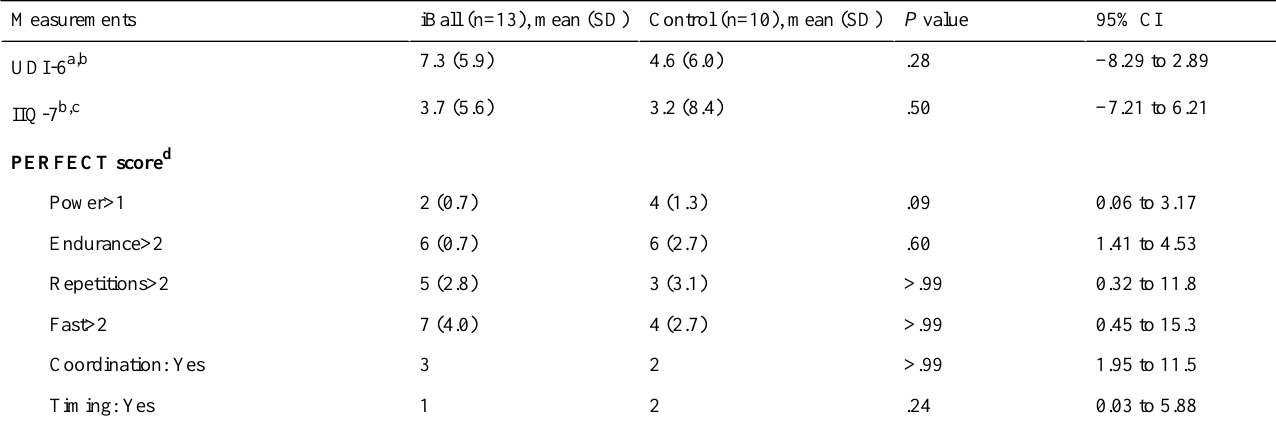
Table 6. Postintervention measurements results between the iBall and the control